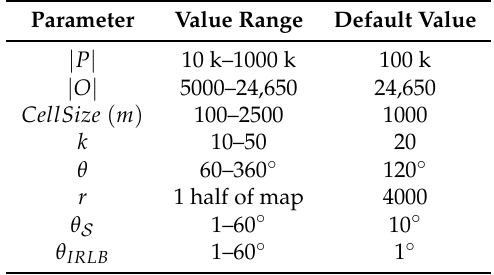
Table 4. Parameters and values of the